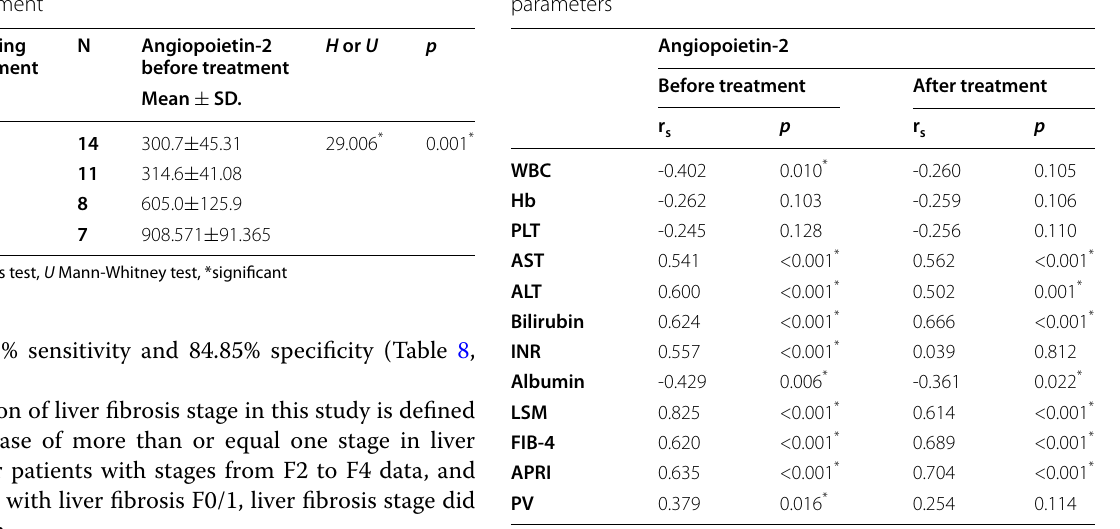
Table 7 Correlation between Angiopoietin-2 and